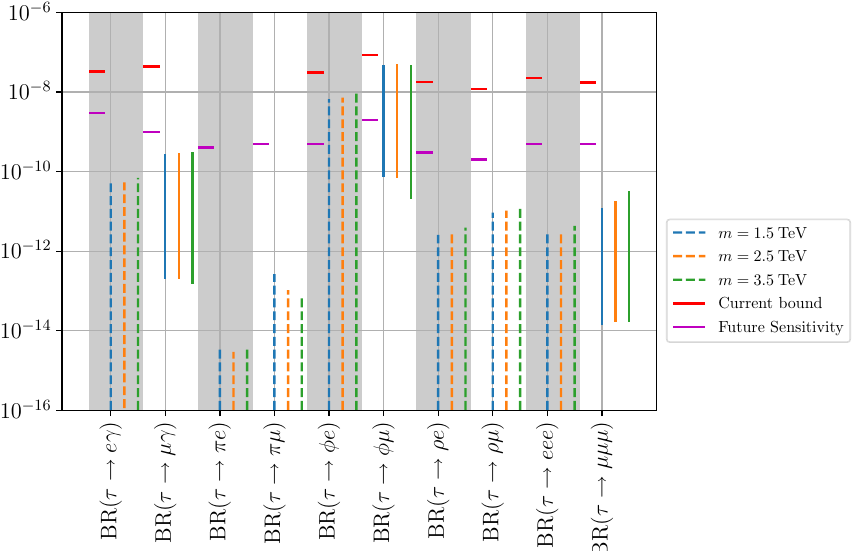
Fig. 5 Lepton flavour violating τ decay modes expected to be searched for at the Belle II experiment. The 90% ranges are obtained from sampling points at the around the best-fit point. Line and colour coding as in Fig. 3